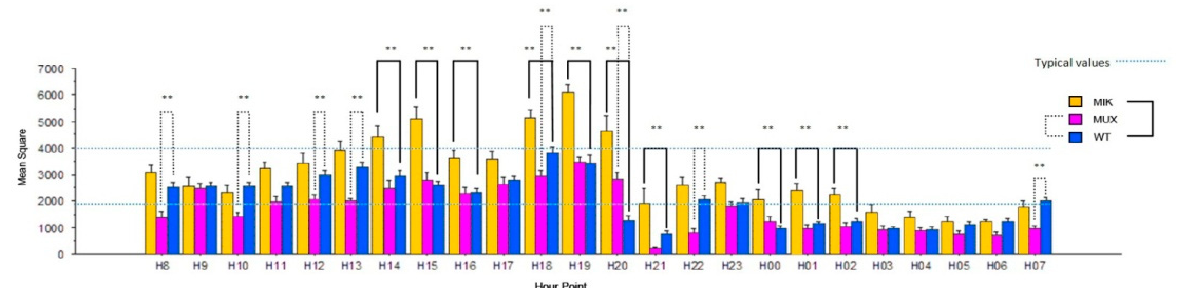
Figure 2. Daily average of locomotor activity in hourly counts for various rat groups: MIK (heterozygous offspring of K-MAT mothers and KO fathers), MUX (heterozygous offspring of KO mothers and MAT fathers, fostered to WT dams) and the WT control group. MIK are genetically MIX (yet with K-MAT rather than MAT mother). The infrared sensor system allowed the measurement of the home-cage locomotor activity: the circadian cycle was monitored over a period of one month, from PND 25 to 55; the daily average was subsequently calculated. The asterisks (**) relate to statistically significant differences ( p < 0.01) between either MIK or MUX and WT (see plain or dashed connectors, respectively).